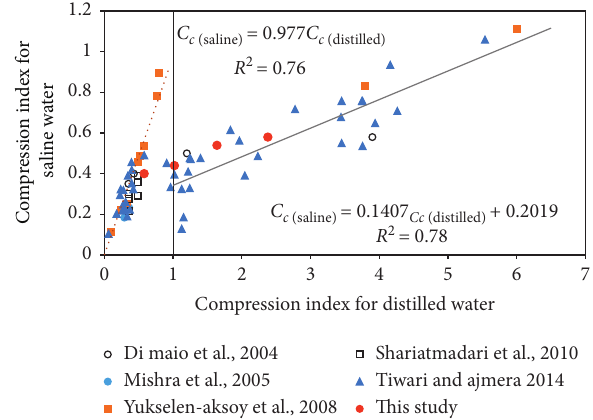
Figure 6: Relationship between compression index for NaCl- treated and untreated soil samples.